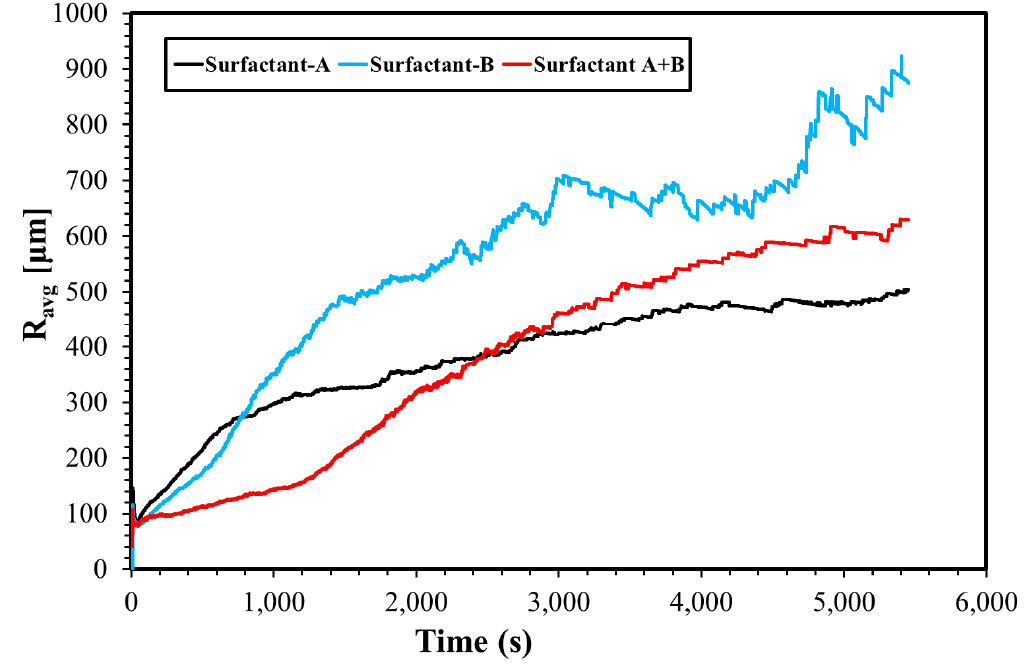
Figure 4. Bubble size of foam generated using different surfactant systems in high salinity brine using air injection at 25 °C.